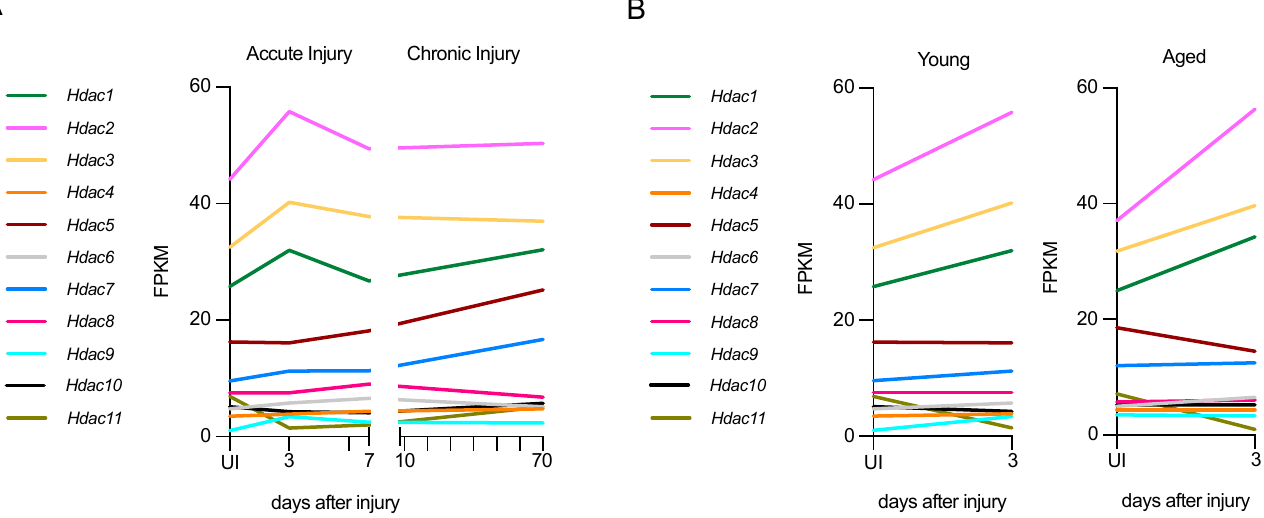
Figure 4. Hdac expression in acute and chronic injury in young nerves or acute injury in aged nerves. ( A ) Hdac expression in young nerves, both in acute (up to 7 days) and chronic injury (up to 70 days). ( B ) Hdac expression in acute injury (3 days) in young and aged nerves. Expression in fragments per kilobase of exon per million mapped fragments (FPKM. Graphs generated based on RNA-seq data from Wagstaff et al., 2021 (ArrayExpress ID E-MTAB-9640) [87]. In chronic lesions, where distal stumps have no axonal contact for a long period of In aged nerves (12-month-old mice), the up-regulation of Hdacs 3 days after time, some Hdacs are persistently upregulated for up to 10 weeks. In particular, Hdac5 and Hdac7 , which are not upregulated in acute injury, show slight but not significant upregu- lation, and Hdac11 is upregulated significantly. By contrast, Hdac6 and Hdac8 are